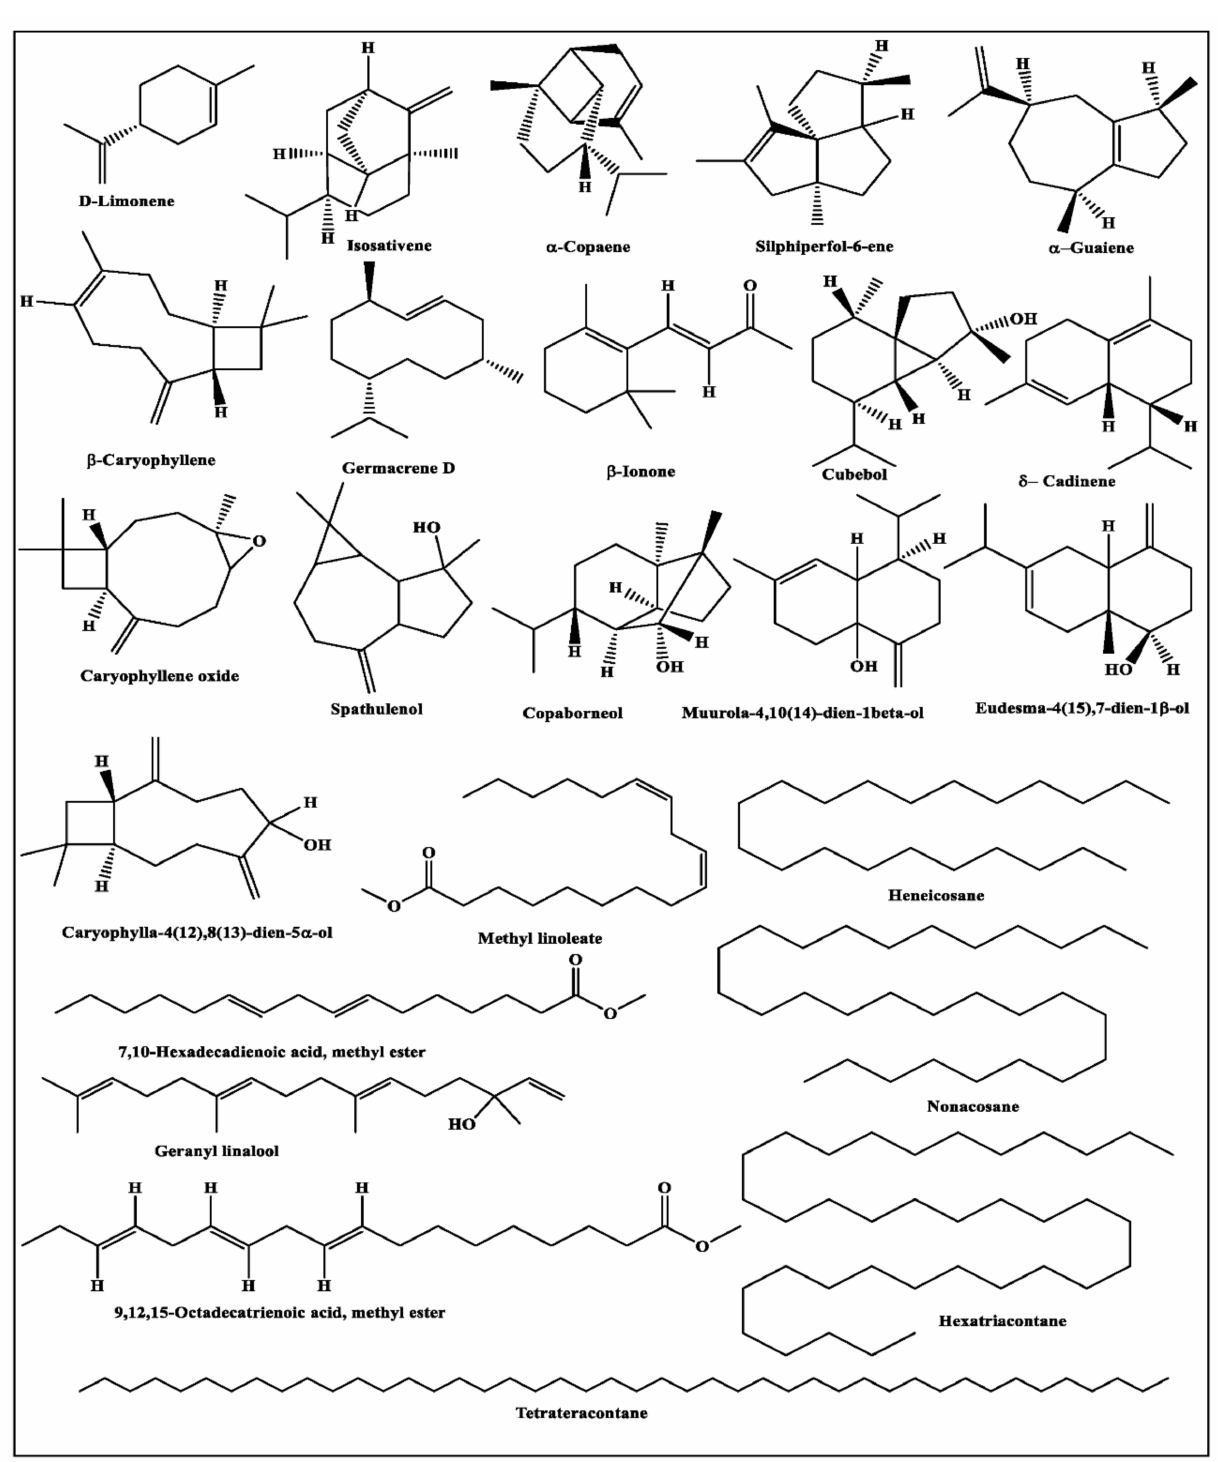
Figure 2. Major components identified in the essential oils obtained from J. intigrimma, J. gossypifolia and J. roseae